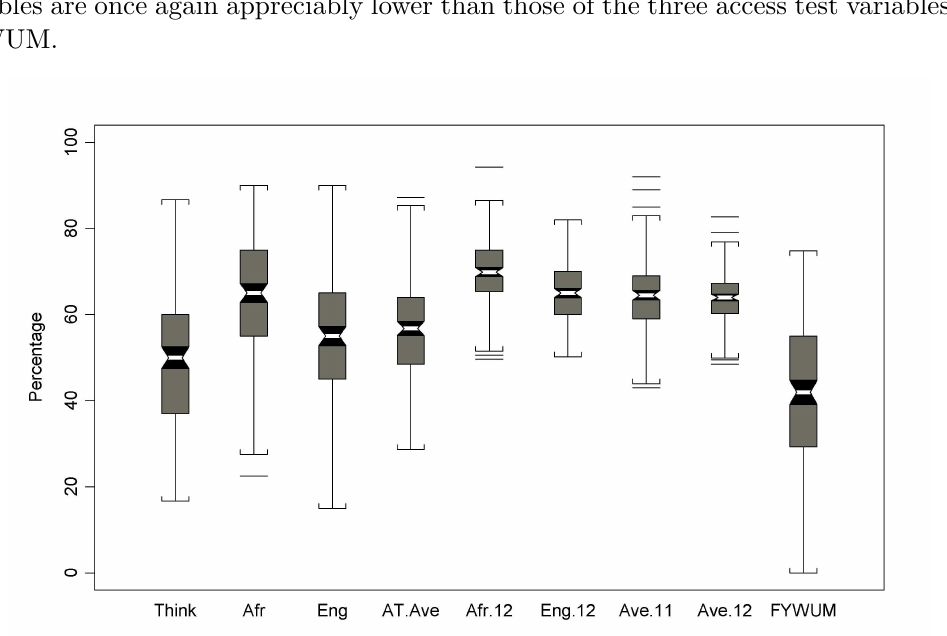
Table 8: Standard deviations of the variables of the Test Battery 3 data set for the 1999, 2000 and 2001 intake groups.